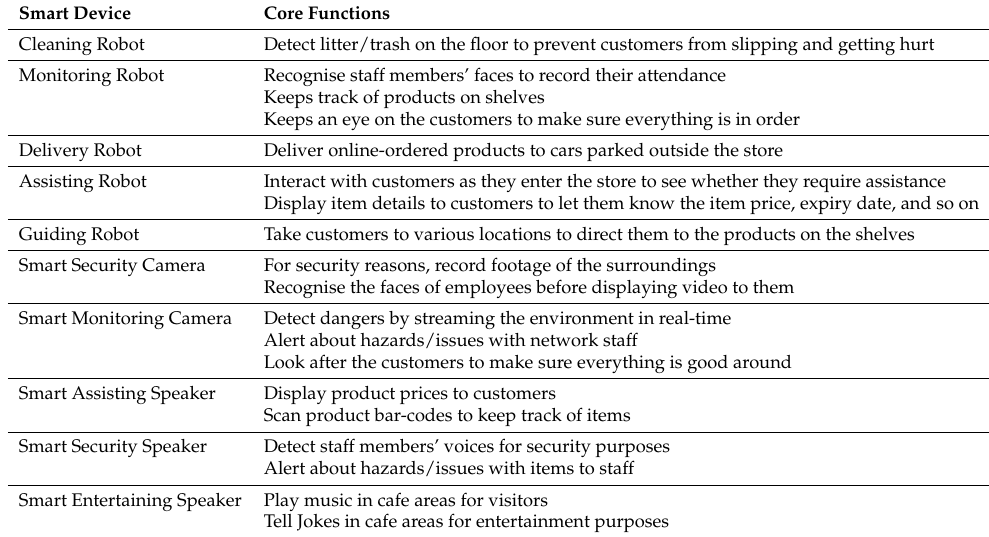
Table 1. Core Functions of Smart Devices in Supermarket